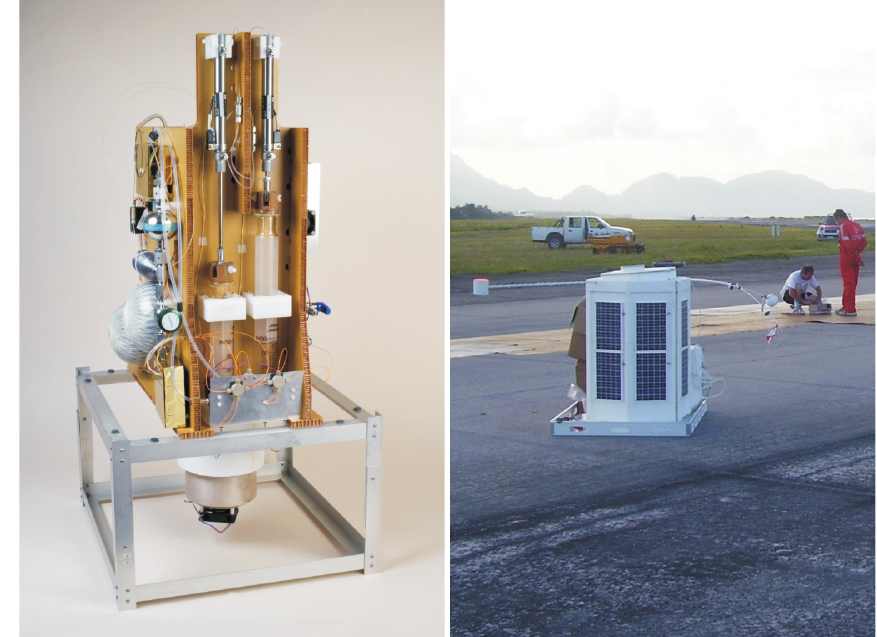
Fig. 4. (left) MIR µ Dirac armature showing twin syringe sample pump; (right) MIR flight housing on the launch pad in Mah´e,